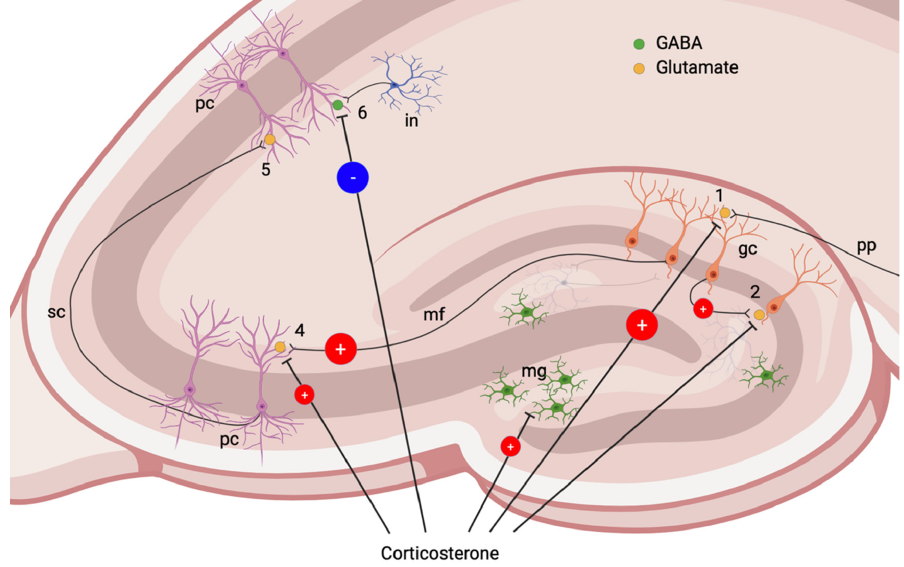
Figure 4. Effects of GCs in chronic stress and structural post-traumatic changes in the hippocampus. GABAergic neuronal loss in the DG and neuroinflammation are histological hallmarks of late post-traumatic changes. 1, Glutamatergic synapse on granular cell. GCs enhance glutamatergic AMPA-mediated signaling [89]. 2, Glutamatergic collateral on granular neuron (mossy fiber sprouting) enhances DG excitability [97]. 4, Glutamatergic synapse on pyramidal neuron of CA3 field. Chronic stress increases EPSP amplitude via NMDA-dependent signaling [87]. Failure of inhibition due to GABAergic neuronal loss is demonstrated [50,98]. 5, Glutamatergic synapse on pyramidal neuron of CA1 field. Though little data on the modulation by chronically elevated GCs of glutamatergic synapses in the CA1 are available, the effects of GCs on pyramidal cells of CA3 field may be similar. 6, GABAergic synapse on pyramidal neuron. Rhythmic IPSCs due to loss of interneurons are demonstrated [94]. pp, perforant path; gc, granular cell; mf, mossy fibers; pc, pyramidal cells (CA3 and CA1 fields); sc, Schaffer collateral; in, interneuron. Red circle (+)—activating action; blue circle ( − )—inhibiting